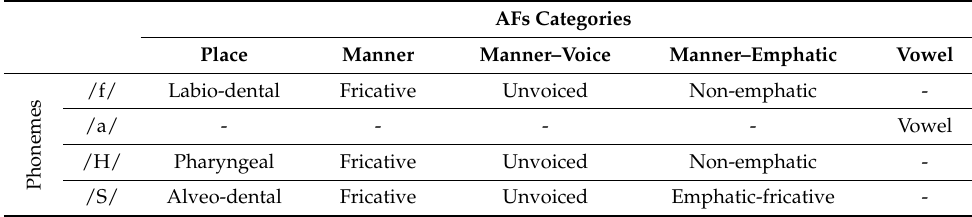
Table 5. Examples of mapping phonemes to their corresponding AFs.